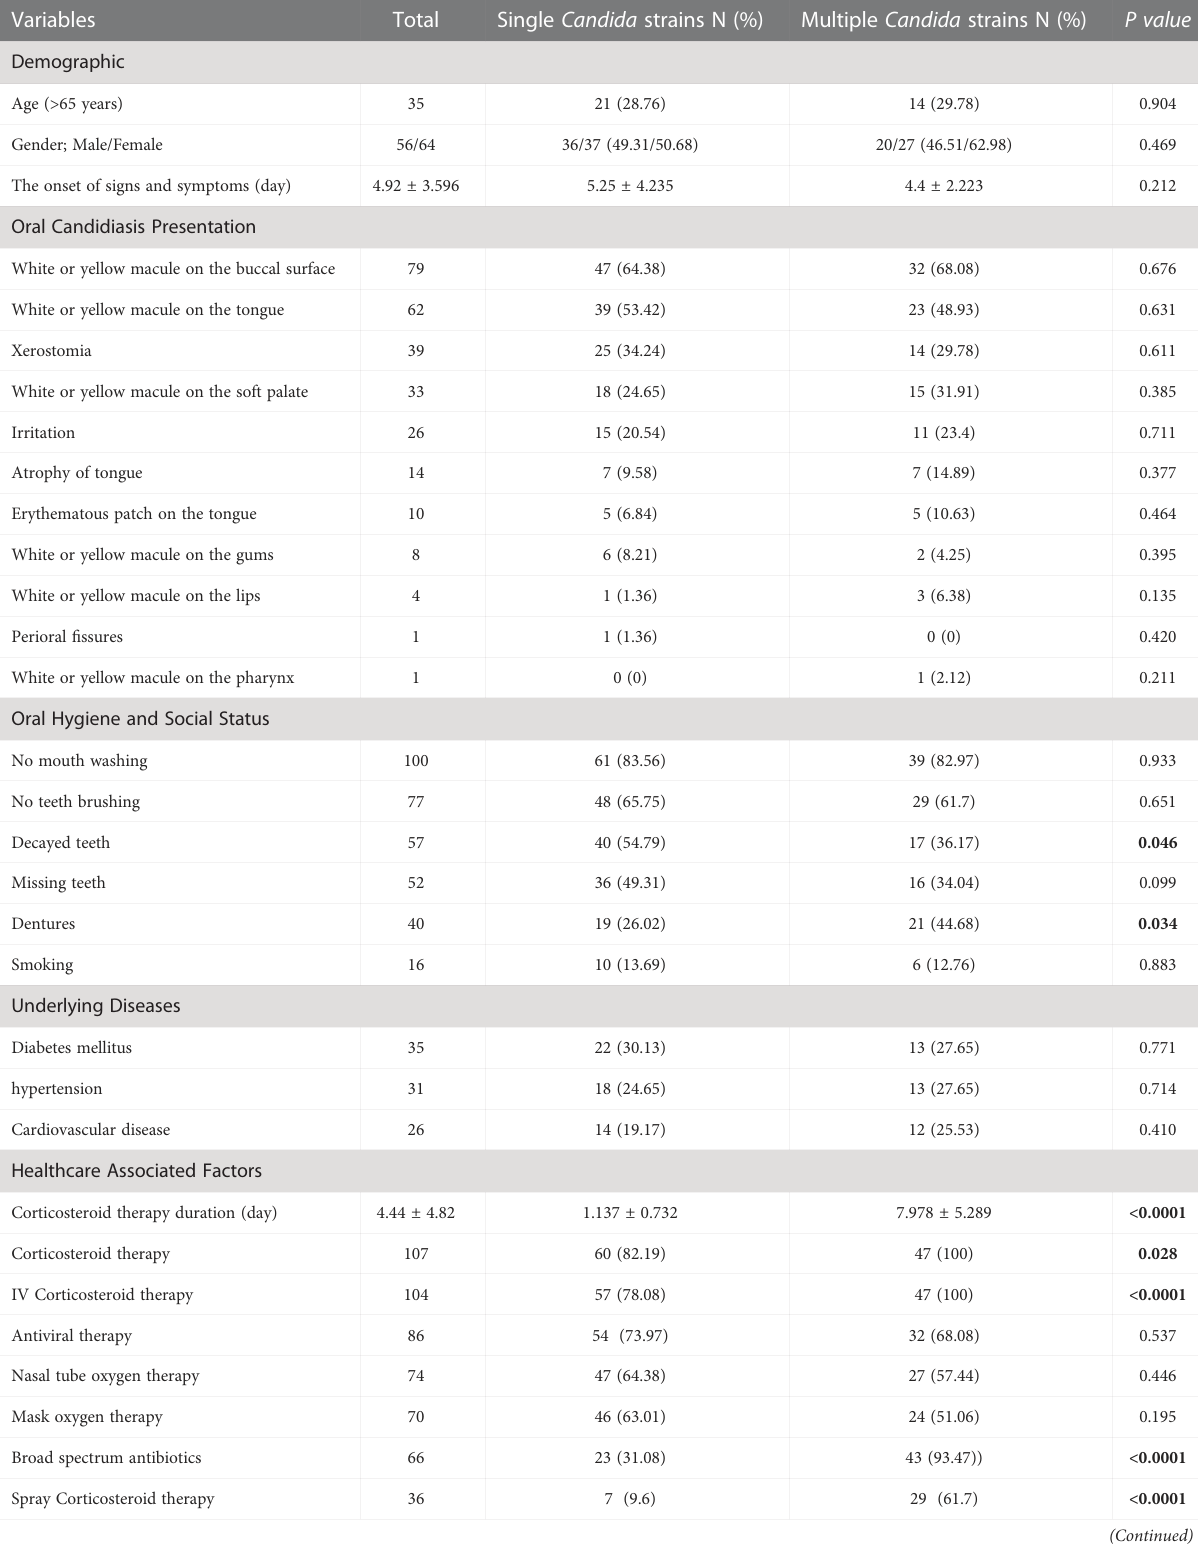
TABLE 2 Oral candidiasis clinical manifestations, comorbidities, social state, and healthcare-associated factors of patients with oral candidiasis caused by single or multiple Candida strains.